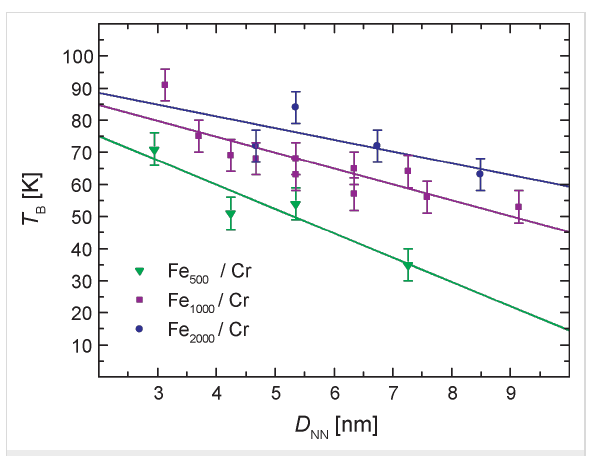
Figure 2: Blocking temperature T B versus approximated nearest neighbor distances D NN for Fe x /Cr samples. The solid lines on three series of samples with 500, 1000 and 2000 atoms are just guides to the eye. A clear dependence of T B on the cluster size as well as D NN is visible.